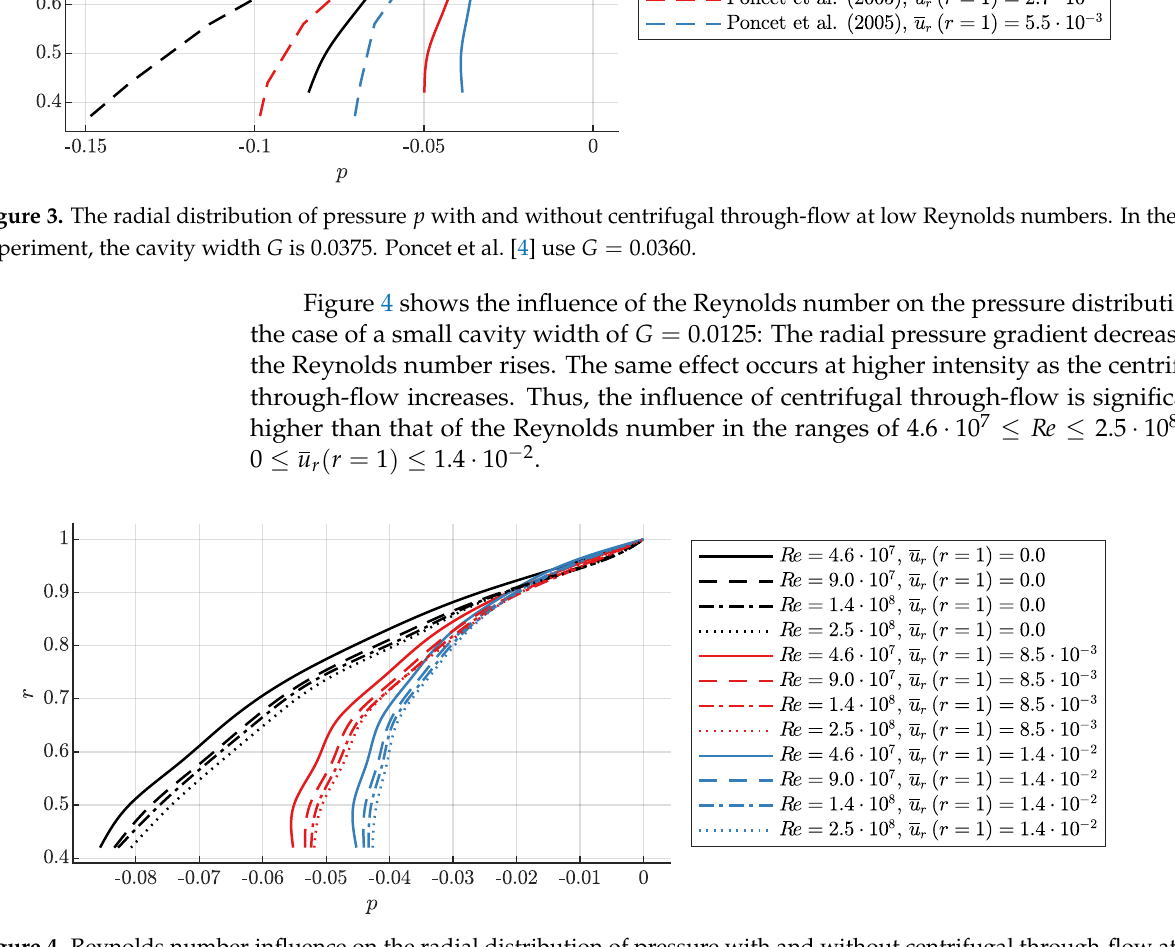
Figure 4. Reynolds number influence on the radial distribution of pressure with and without centrifugal through-flow at the small cavity width. Experimental